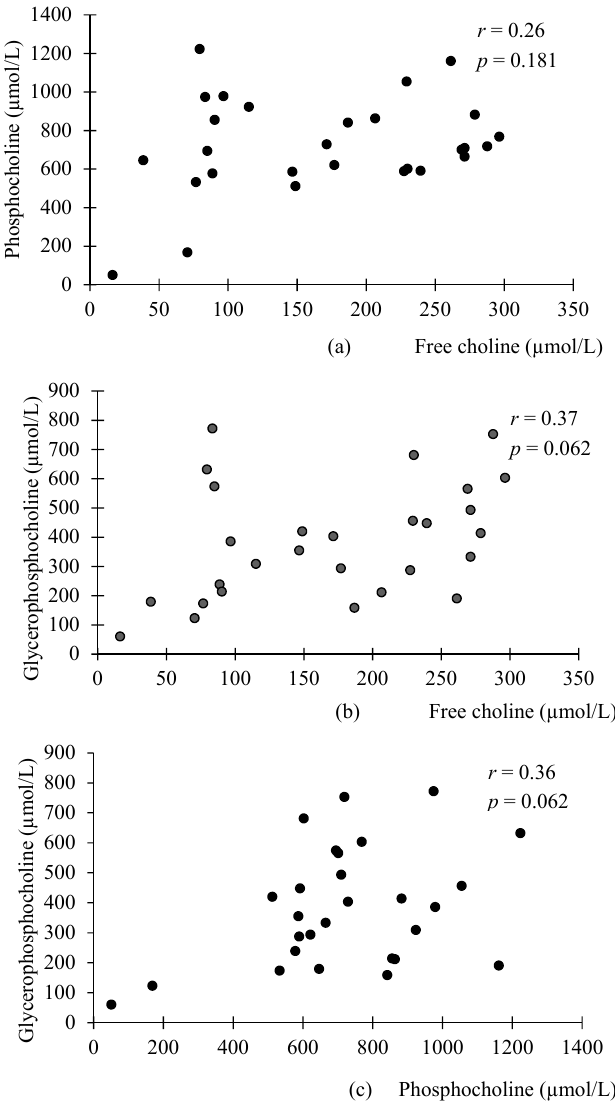
Figure 2. Scatterplots of the relationship between the different water-soluble choline compounds in term donor milk: ( a ) no significant association between phosphocholine and free choline in term donor milk; ( b ) no significant association between glycerophosphocholine and free choline in term donor milk; ( c ) no significant association between glycerophosphocholine and phosphocholine in term donor milk. n = 30; associations were analyzed using Spearman’s